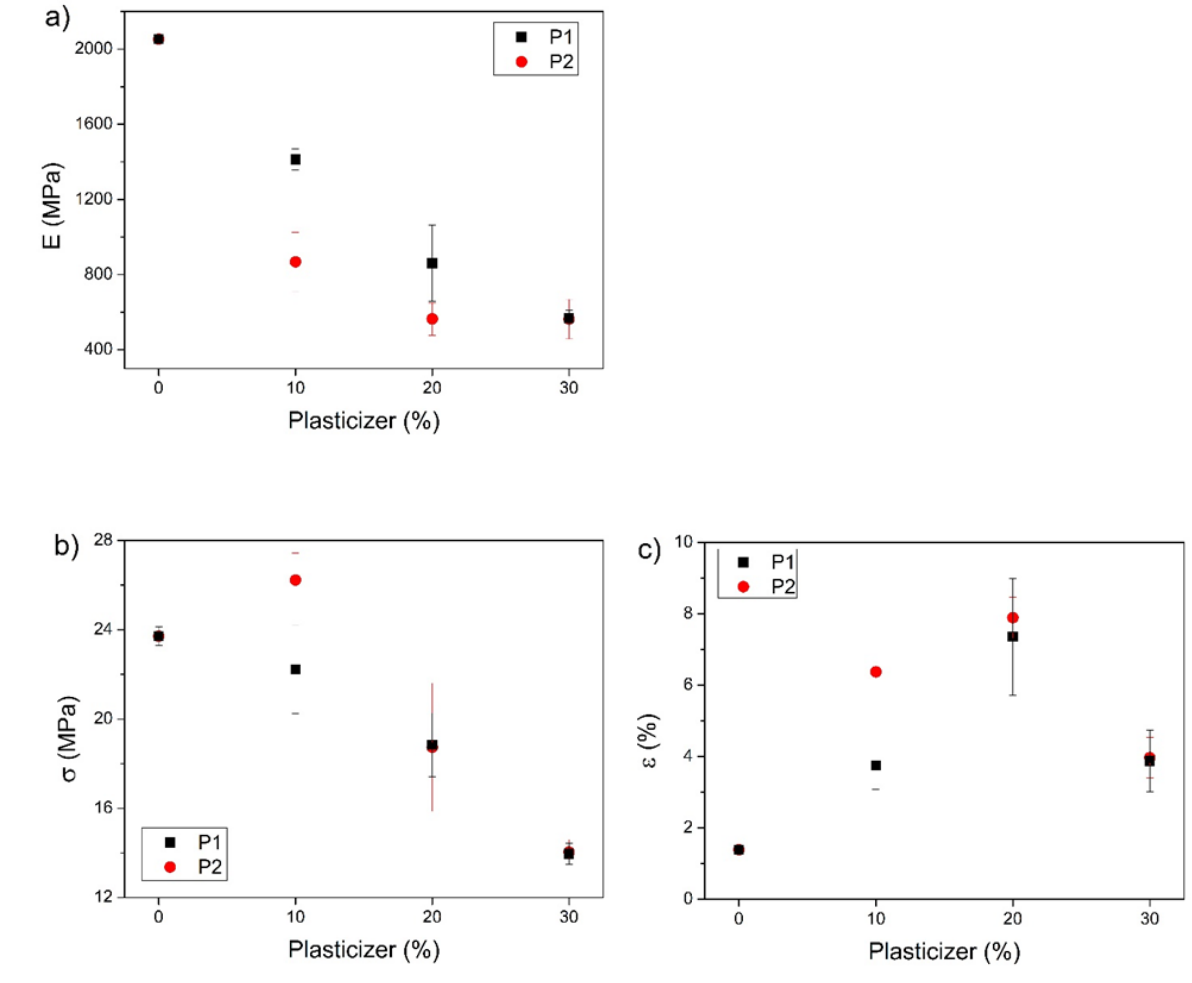
Figure 9. Tensile properties of PHB, PHB/P1, and PHB/P2 blends. ( a ) Elastic modulus (E); ( b ) tensile strength ( σ ); ( c ) elongation at break ( ε ).